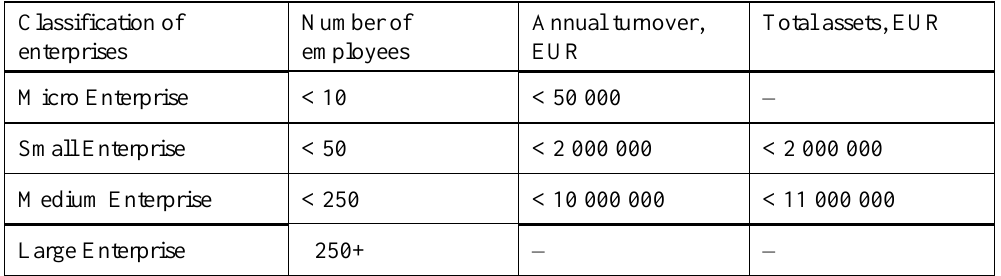
Table 4. Classification of enterprises by size in Macedonia